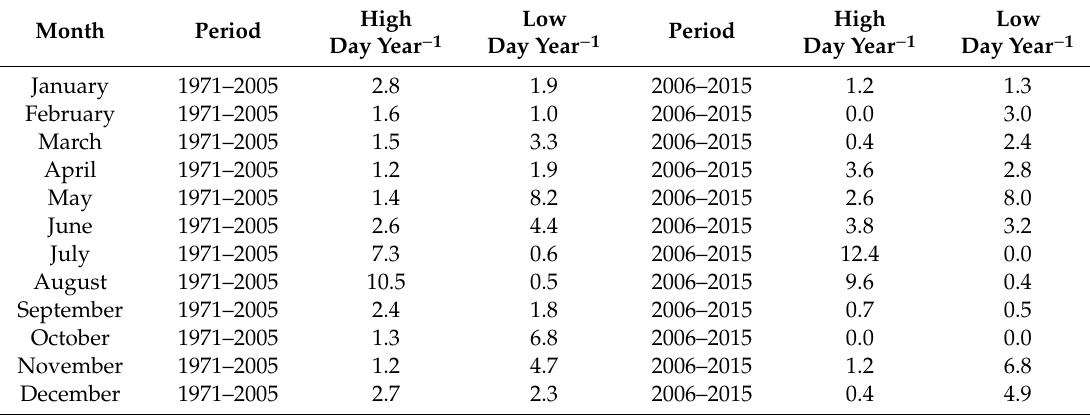
Table A2. Number of days with extremely low ( < 10th percentile; 669 m 3 s − 1 ) and high ( > 90th percentile; 2830 m 3 s − 1 ) flows of the Po River in each month, in 1971–2005 and 2006–2015. The data are normalized for the length of the two